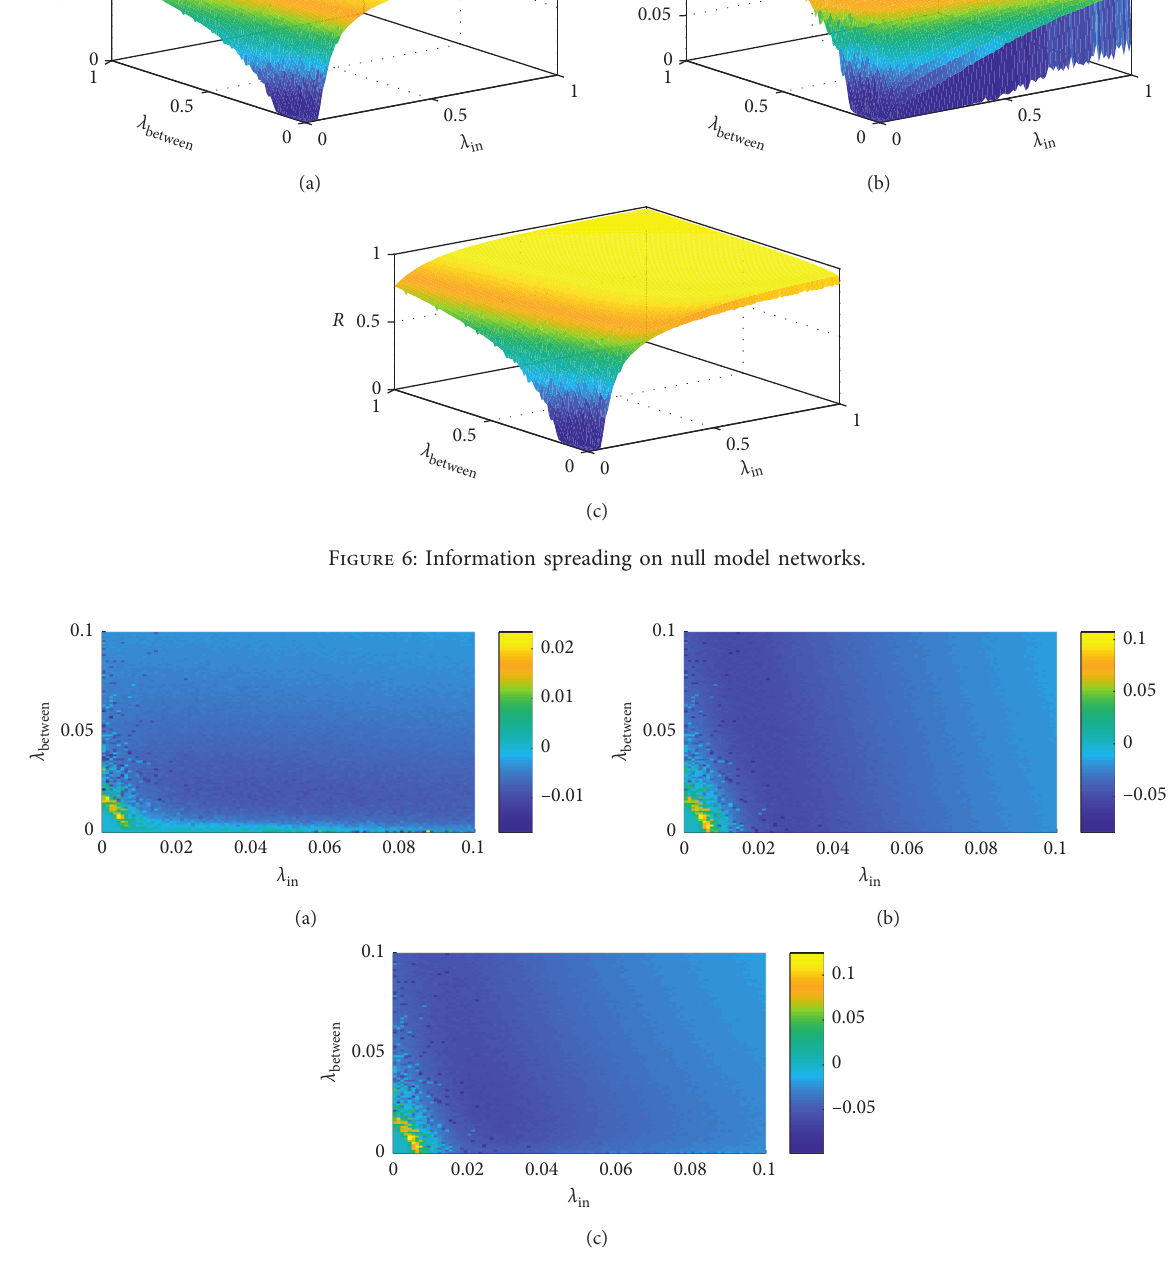
Figure 7: Difference of information spreading on real-world and null model